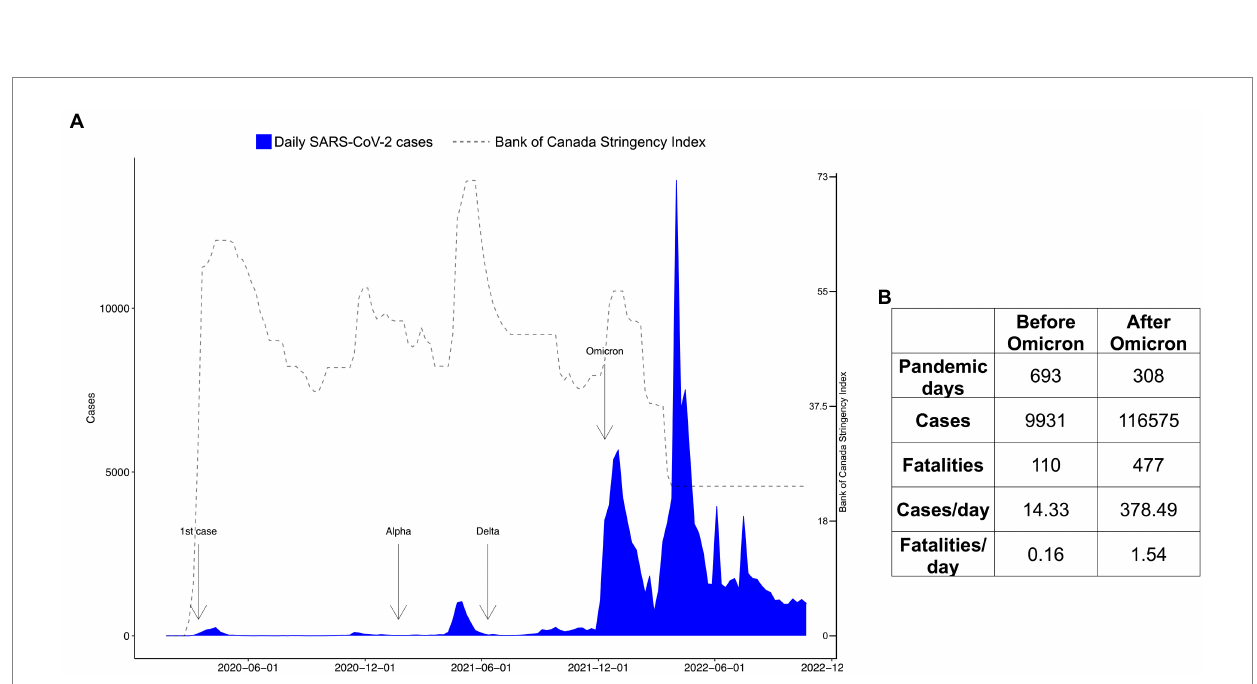
FIGURE 3 Variant timeline and pandemic figures in Nova Scotia before and after Omicron. In (A) , we show the weekly report on COVID-19 cases in Nova Scotia as well as a timeline of the Variants of Concern (VoCs). The first case was reported in the province on 2020-03-15. The reports of the introduction of VoCs are annotated in the plot as follows: the first case of the Beta (UK) variant on 2021-01-22; the first case of the Delta variant on 2021-06-11; and the first Omicron case on 2021-12-12. To track the VoCs, we obtained news data from https://signalhfx.ca/covid-19-in-nova-scotia-2021/ and https:// ipac-canada.org/covid-19-variants-of-concern. In (B) , we show the number of pandemic days, number of cases, and fatalities in the time period before Omicron (from 2020-01-25 to 2021-12-12) and after Omicron (from 2021-12-13 to